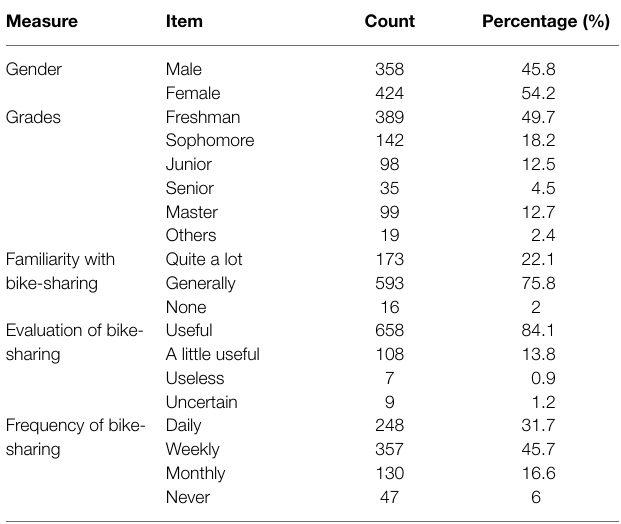
TABLE 1 | Demographics and relevant frequency